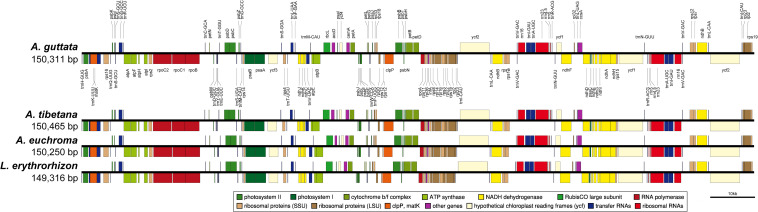
Linear gene map of chloroplast genomes from Arnebia and Lithospermum species. Genes are transcribed left to right. Genes above the line are positioned in the forward direction (left to right). Genes below the line are positioned in the reverse direction (right to left).